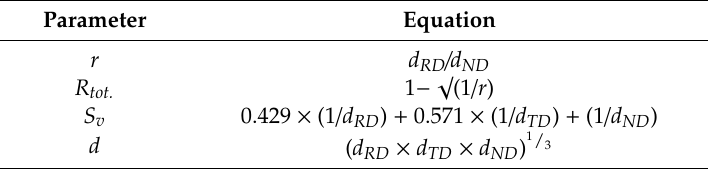
Table 3. Austenite grain structure parameters, data from reference [10].